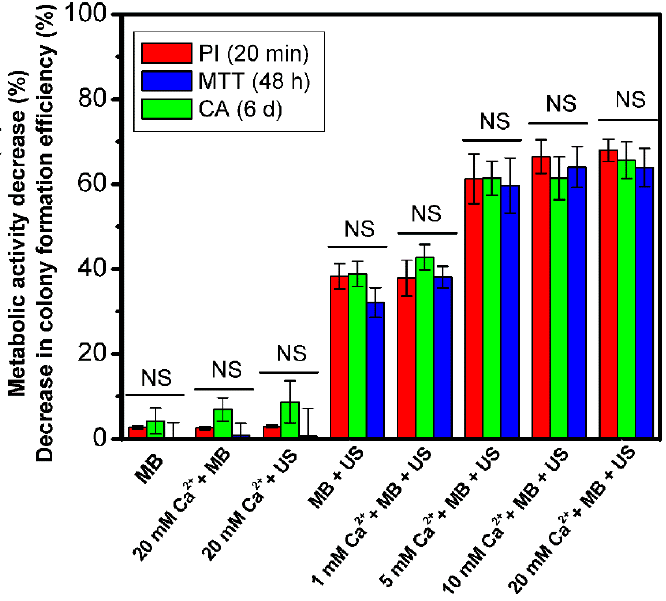
Figure 7. Cell membrane permeabilization, decrease in metabolic activity and decrease in colony formation efficiency, evaluated after SP for different experimental groups and compared within. “NS” indicates no significance between experimental groups (one ‐ way ANOVA).